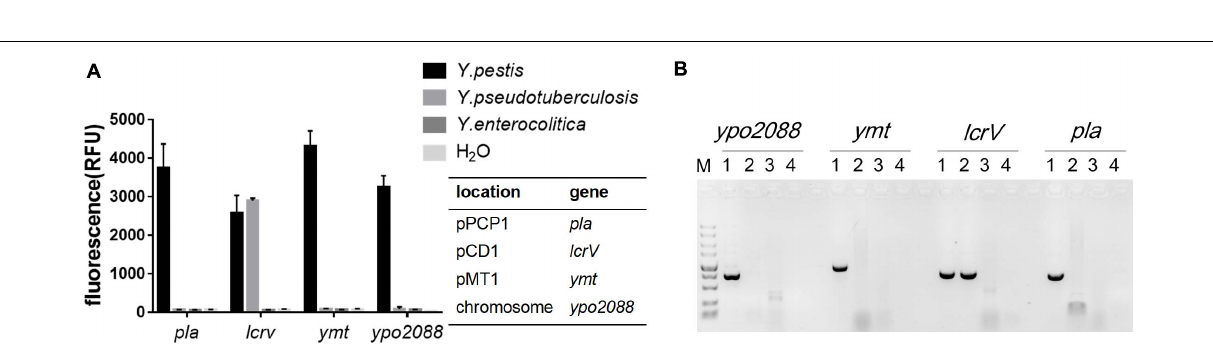
Frontiers in Microbiology |